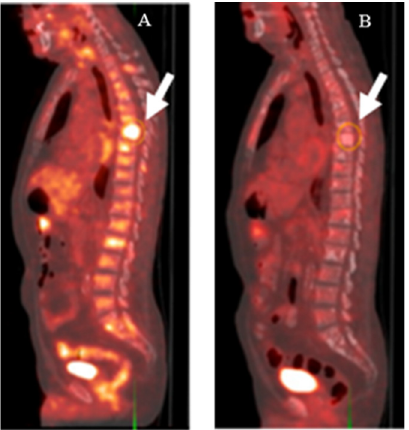
Figure 2. [ 18 F]FDG-PET imaging of a patient with CRPC before ( A ) and after ( B ) treatment with docetaxel. Metabolic activity in thoracic spine lesions (white arrows) decreased after treatment. This research was originally published in the Journal of Nuclear Medicine (JNM) [17].